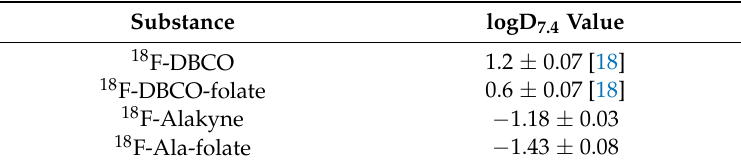
Table 1. LogD values at pH 7.4 via shake-flask method.